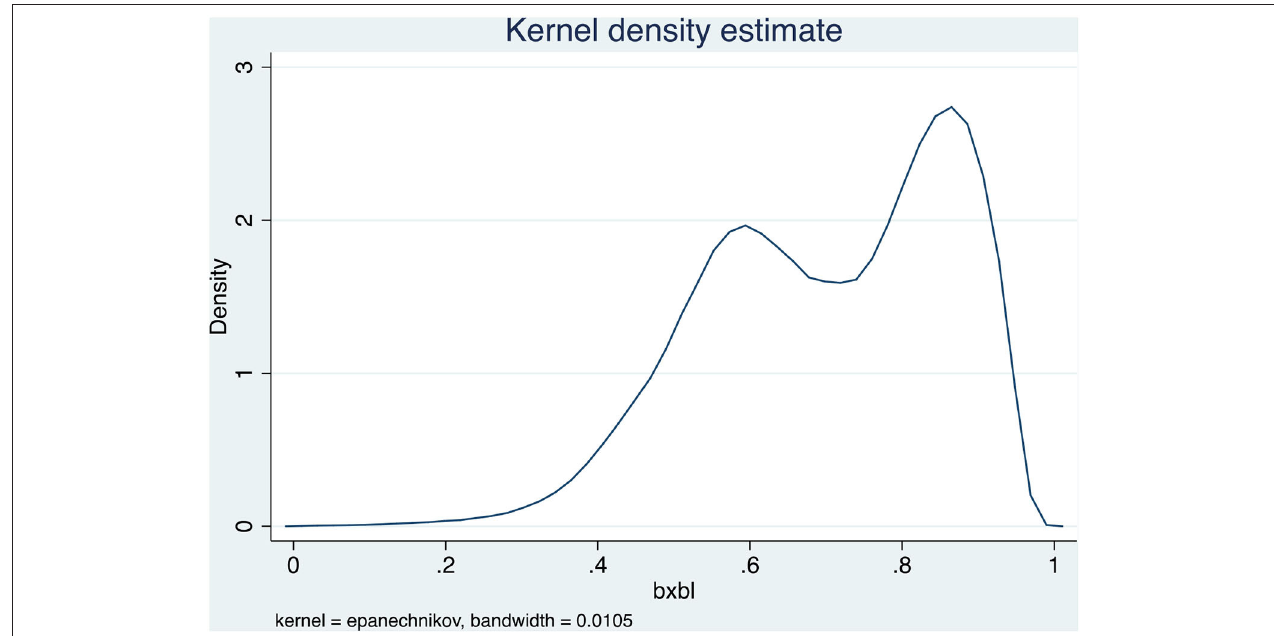
FIGURE 2 | The density chart of reimbursement rates of medical insurance for different hospitals grades.